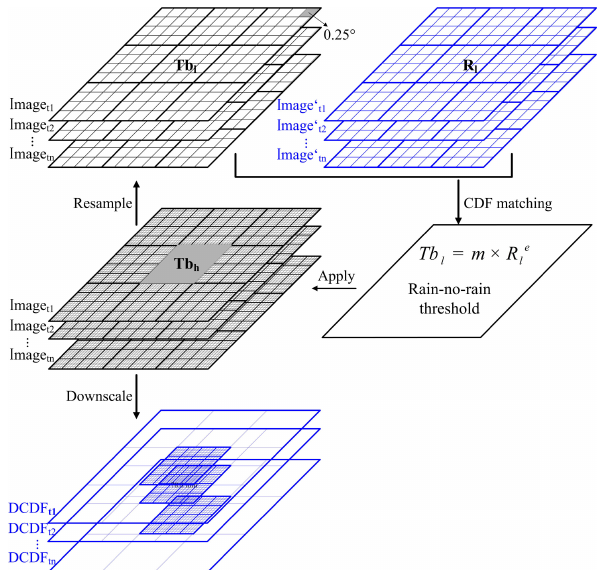
Figure 3. Schematic of the CDF-based downscaling method (DCDF) using CMORPH and FY2-E T b in this study. R represents the precipitation